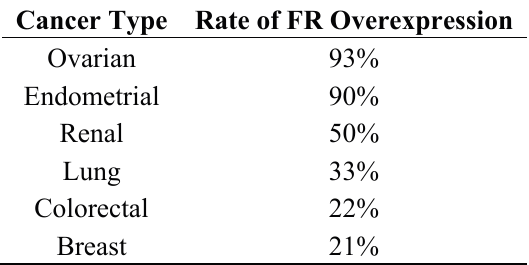
Table 1. Folate receptor overexpression in different cancer types [100]. FR, folate